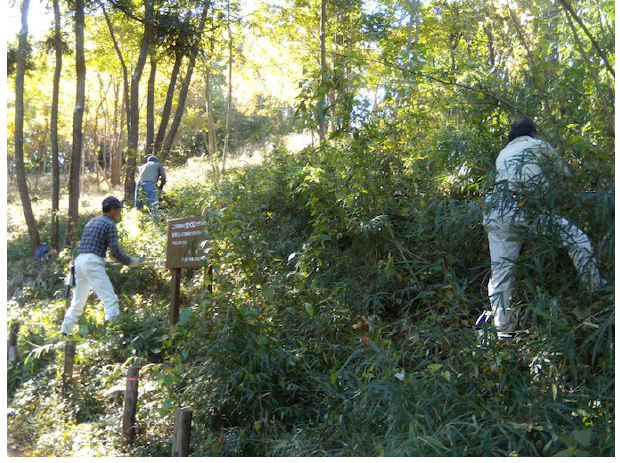
Fig. 2 . Example of community group activity at peri-urban satoyama